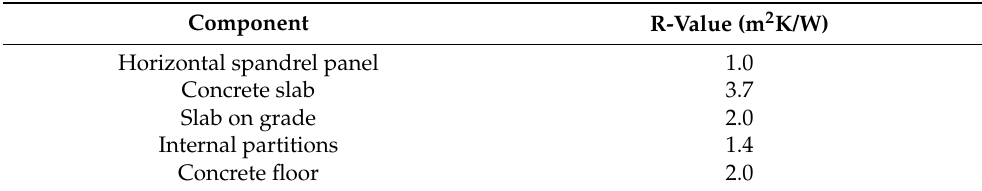
Table 1. Thermal performance of the opaque elements of the envelope. Modelled based on standard values reported by the NCC [40].